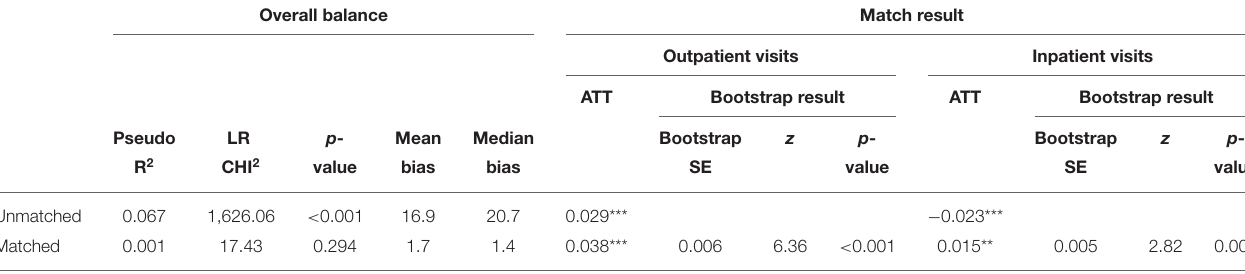
TABLE 2 | Overall balance t -test and the average treatment effect on the treated of social participation. Overall balance Match result Outpatient visits Inpatient visits ATT